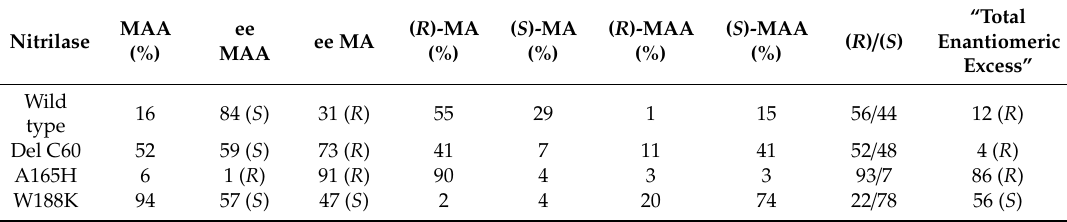
Table 1. Examples for the calculation of the “total enantiomeric excess” observed during the conversion of ( R , S )-mandelonitrile to mandelamide and mandelic